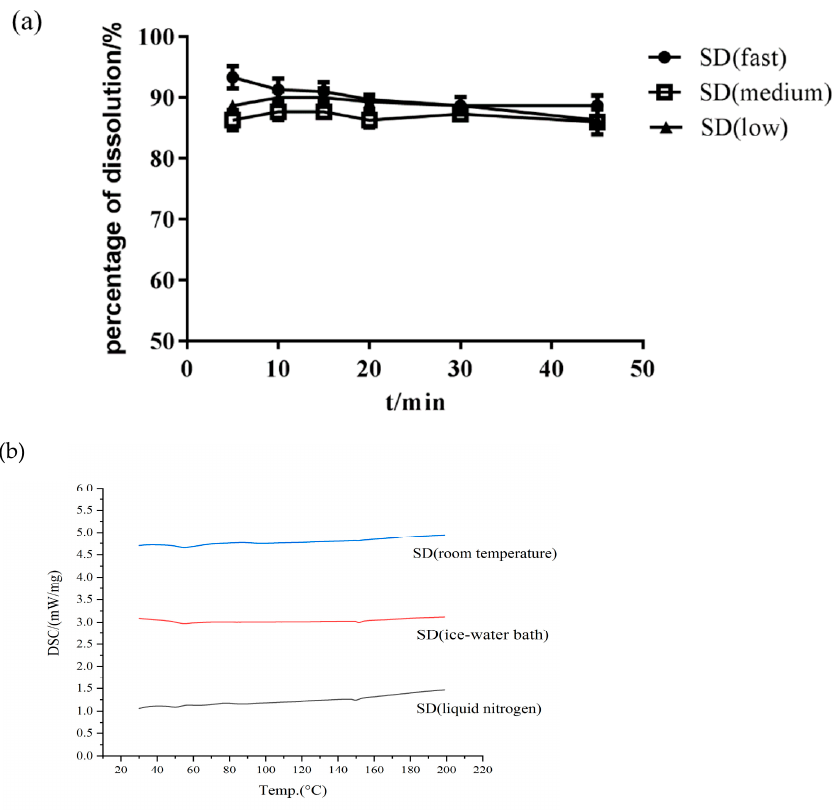
Figure 6. The dissolution of SD ( a ) and DSC curves ( b ) with different cooling methods.